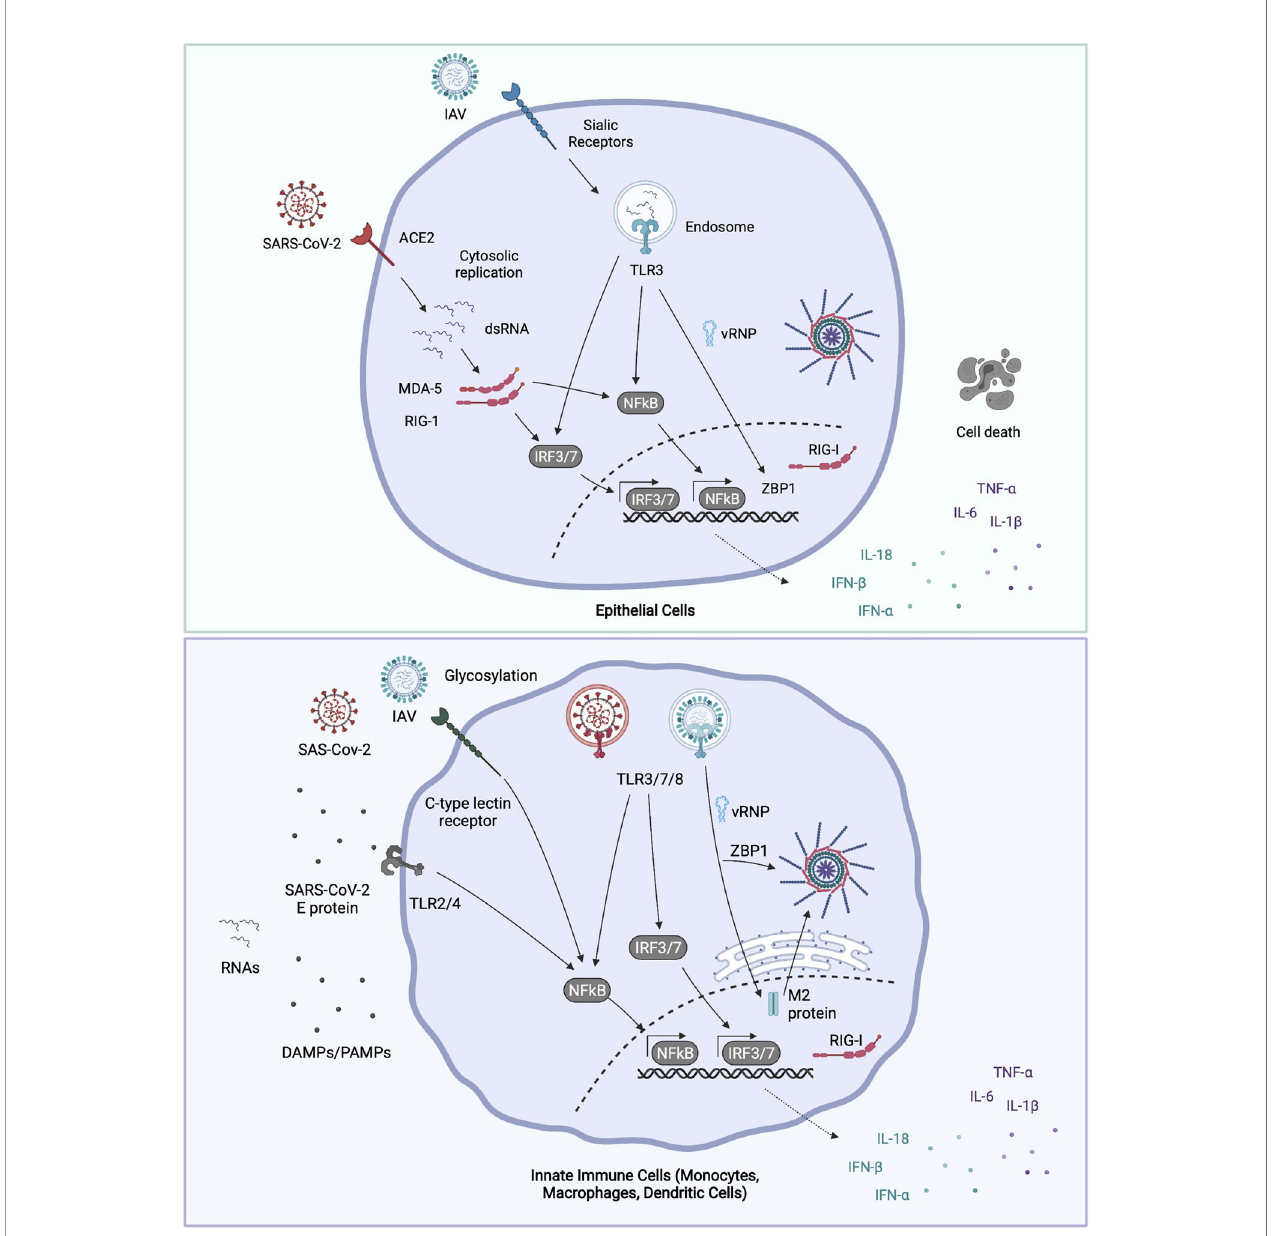
FIGURE 1 | Molecular sensing of IAV and SARS-CoV-2. IAV binds to surface a 2,6-linked sialic acid ( a 2,6-SA) receptors on airway epithelial cells, and some macrophages, whereupon it ’ s internalized into endosomes (76). Incoming virions may be sensed by TLR3 (epithelial cells) or by TLR3, 7 and 8 (macrophages and dendritic cells). TLR engagement leads to NF k B and IRF transcription factor activation and pro-in fl ammatory and anti-viral gene expression. Post fusion, viral RNA bound by nucleoprotein (vRNPs) are released into the cytosol. Once in the cytosol, vRNPs are traf fi cked to the nucleus where IAV replicates. IAV replication products are sensed by nuclear RIG-I or ZBP1, triggering gene expression or cell death respectively. ZBP1 may also intercept vRNAs in the cytosol and trigger in fl ammasome activation. Newly synthesized IAV M2 protein can trigger NLRP3 in fl ammasome activation and IL-1 b release. SARS-CoV-2 enters airway epithelial cells via ACE2, and after fusion at or near the plasma membrane, the viral genome is released into the cytosol. The dsRNA intermediates generated during SARS-CoV-2 replication are sensed by both RIG-I and MDA-5 in the cytosol, leading to NF k B and IRF3 activation. Dendritic cells and macrophages do not appear to be productively infected with SARS-CoV-2 (71). Though whether they can still take up virus, and signal from endosomal TLRs isn ’ t known. TLR7 in plasmacytoid dendritic cells recognises either virions or ssRNAs from SARS-CoV-2. Extracellular viral PAMPS and DAMPS released from neighbouring infected cells can also be sensed by surface and endosomal TLRs [e.g., SARS-CoV-2 envelope ‘ E ’ protein: TLR2 (74)], driving NFkB activation. Glycosylated viral proteins can further be detected by CLRs expressed on macrophages, which drives NF k B activation (77). Figure created with